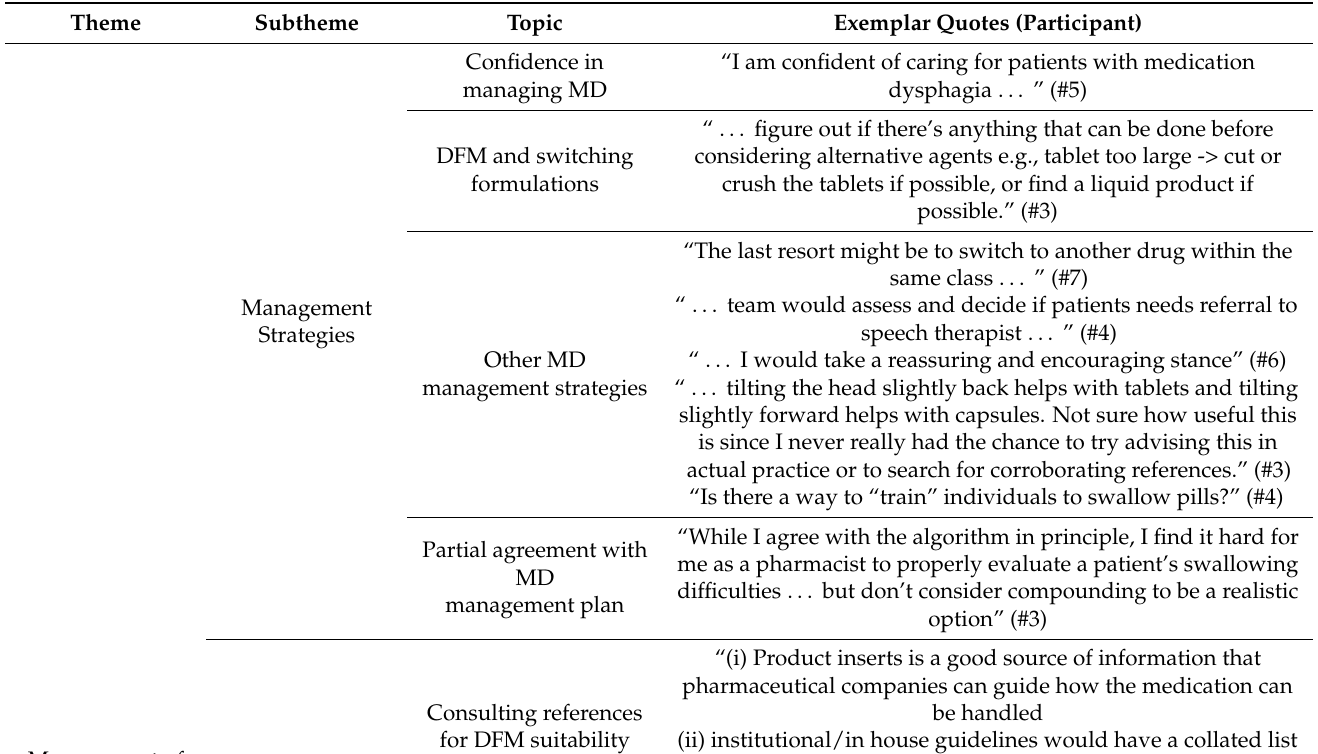
Table 3. Minor theme of management of medication dysphagia, corresponding subthemes, and exemplar